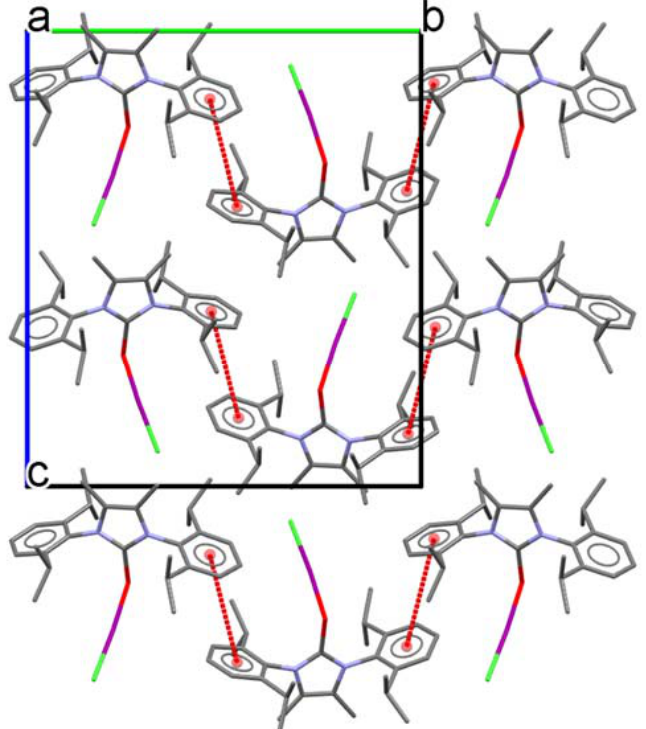
Figure 3. Packing in the crystal structure of Compound 4 , viewed down the a-axis with indicated π - π interactions between both 2,6-diisopropylphenyl ring centroids and their symmetry-equivalents. Hydrogen atoms and solvent molecules are omitted for clarity.